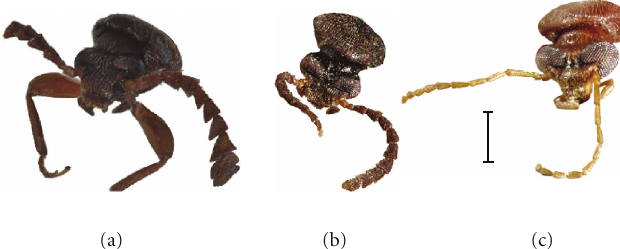
Figure 4: Head and prothorax of Scaphinion . (a) S. clavatus ; (b) S . sp. 1; (c) S. sp. 2. Scale line 1 mm for all